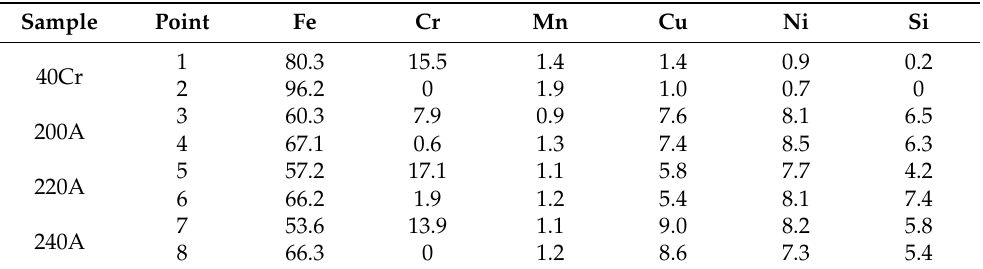
Figure 7. SEM images of the wear morphology of the 40Cr and FeCrMnCuNiSi 1 high-entropy alloy coatings at different melting currents. ( a – c ) Substrate; ( d – f ) 200 A; ( g – i ) 220 A; ( j – l ) 240 A. Table 3. EDS of the friction and wear scar structures of the FeCrMnCuNiSi 1 high-entropy alloy coating under the substrate and different cladding